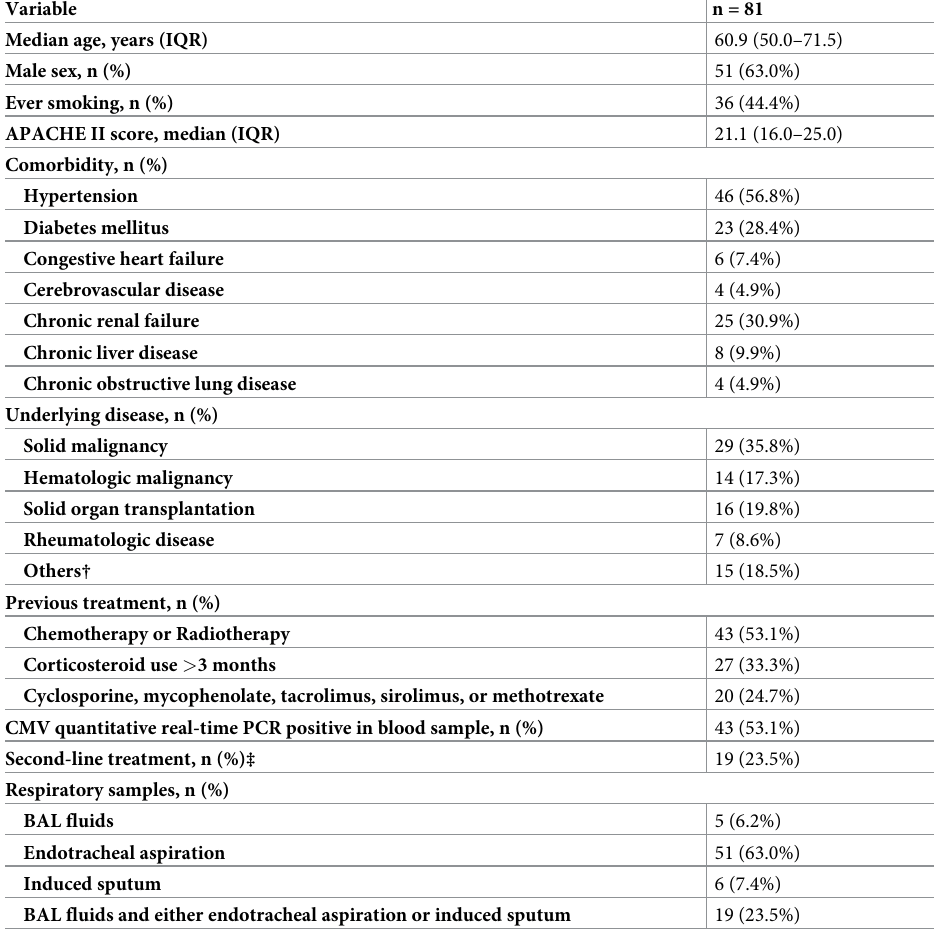
Table 1. Baseline characteristics of non-HIV PCP patients with respiratory